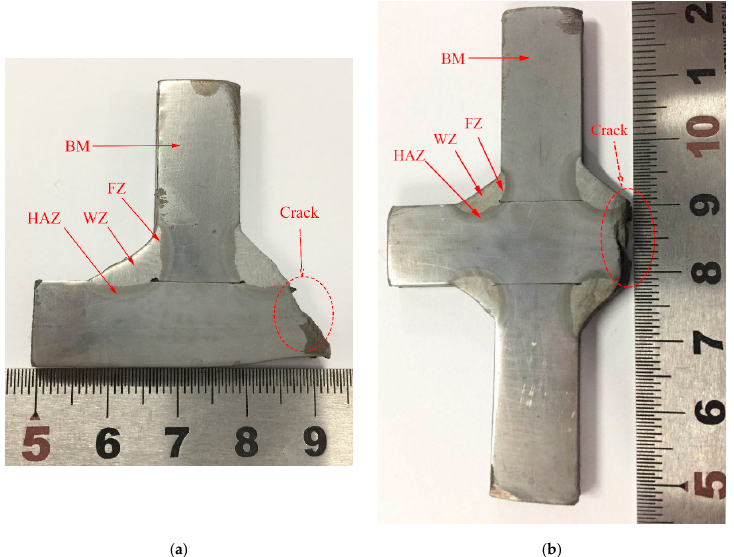
Figure 2. The profile of T-and cruciform welded joints: ( a ) T-welded joints and ( b ) cruciform welded joints (BM: Base Metal, FZ: Fusion Zone, WZ: Weld Zone, HAZ: Heat Affected Zone).